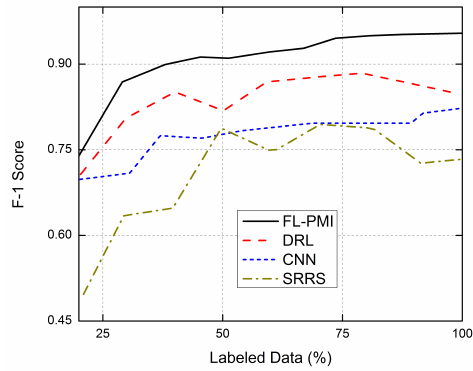
Figure 3. Analysis of auto-labelling in terms of the F1-score.